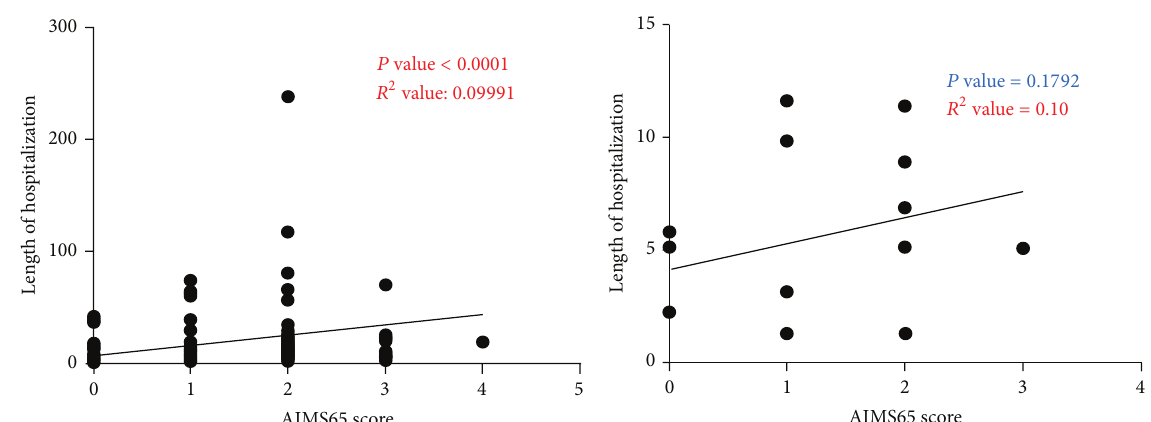
Figure 7: Statistically significant direct correlation was found between the length of hospitalization and AIMS65 scores in noncirrhotic patients but not cirrhotic patients.